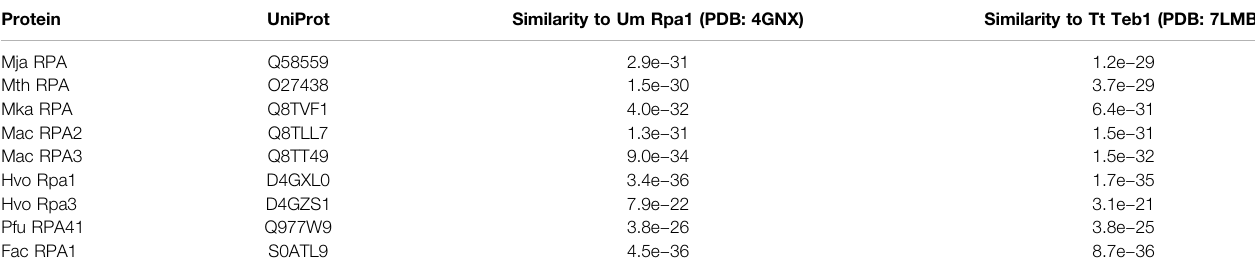
TABLE 1 | Archaeal Rpa1-like protein similarity scores. Protein UniProt Similarity to Um Rpa1 (PDB: 4GNX) Similarity to Tt Teb1 (PDB: 7LMB)